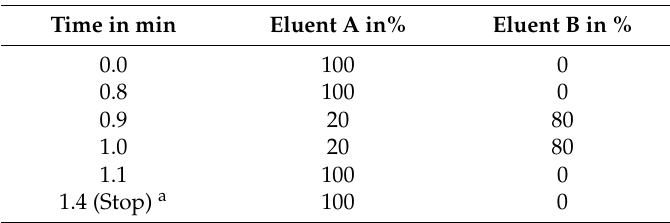
Table A5. Elution program for 2